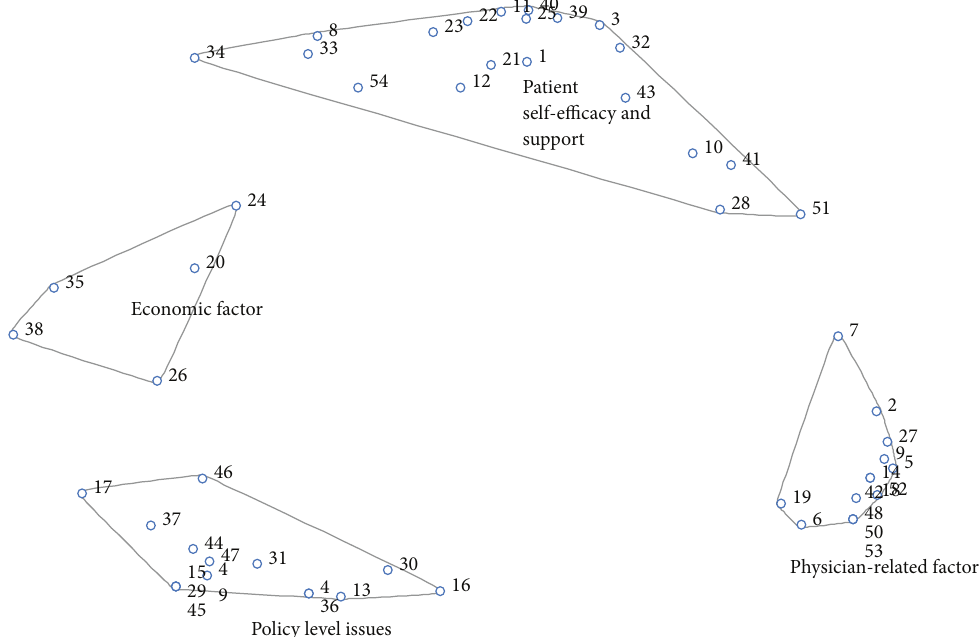
Figure3:Finalclustermapbasedonparticipantsorting.Eachofthefourclustersidentifiedbyphysiciansisrepresented.Numberscorrespond to statements that were sorted into each category. Items that are closer together indicate higher degrees of similarity based on